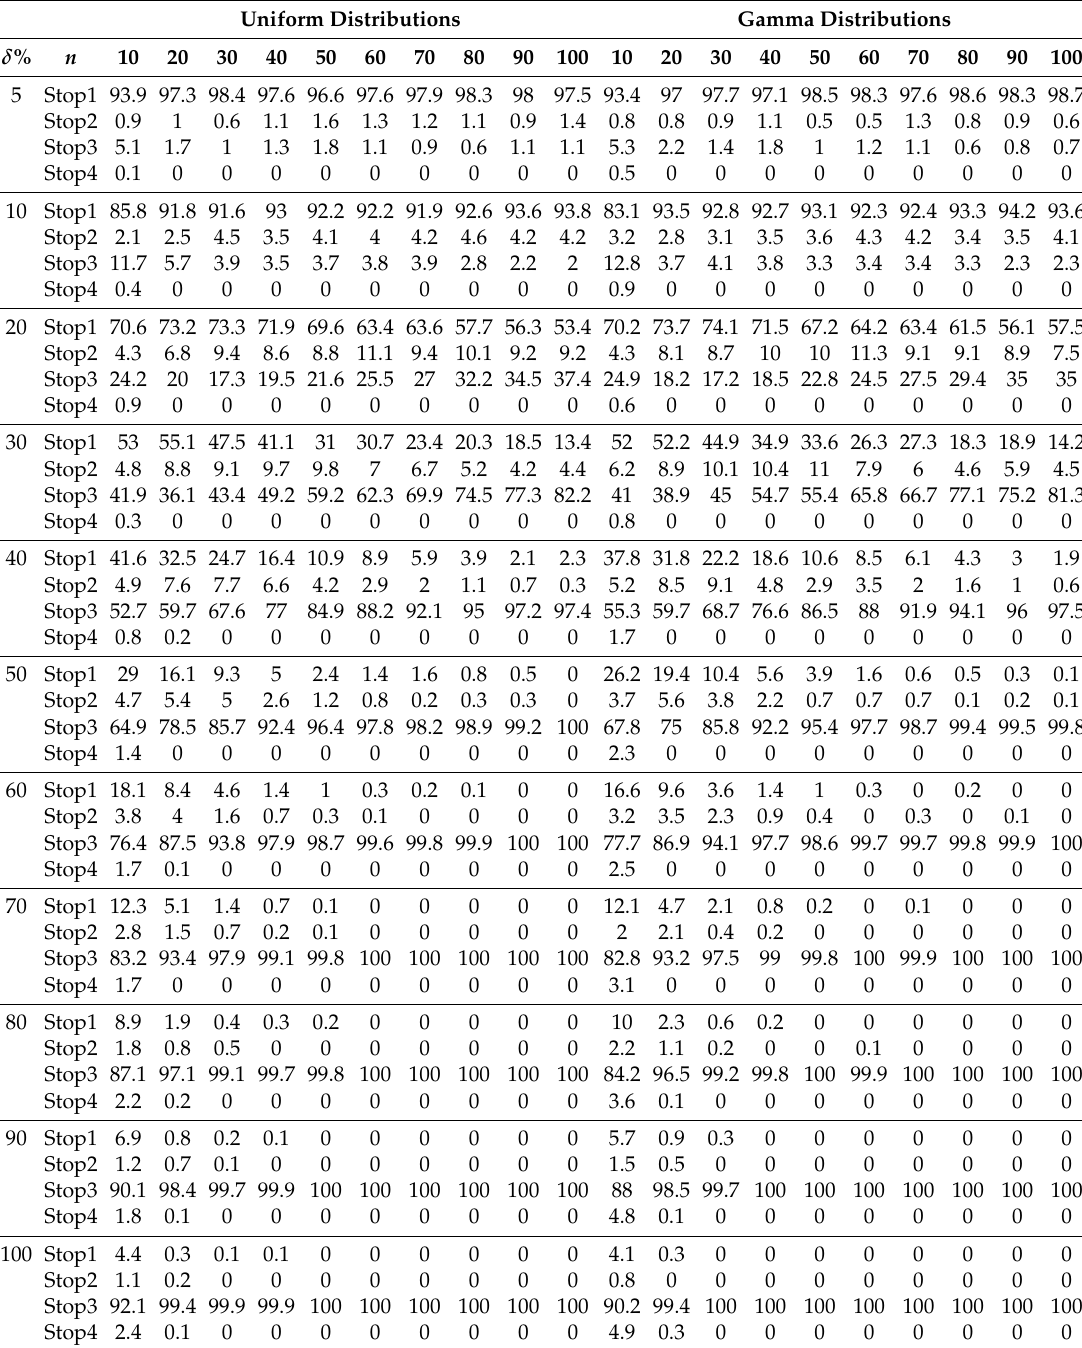
Table A1. Computational results for the randomly generated instances with the ratio